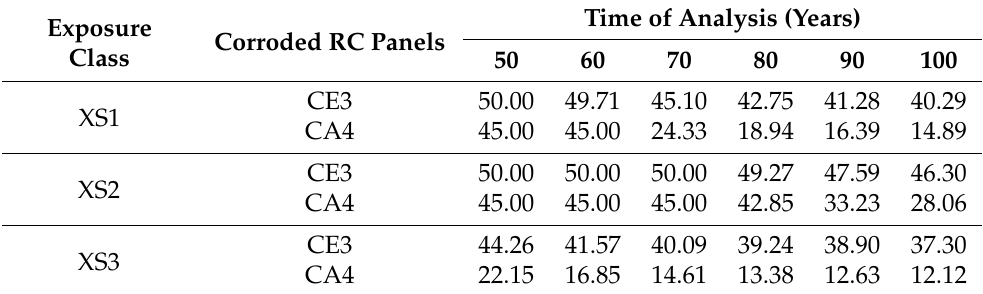
Table 4. Reduced compressive strength of concrete over time for the two RC panels